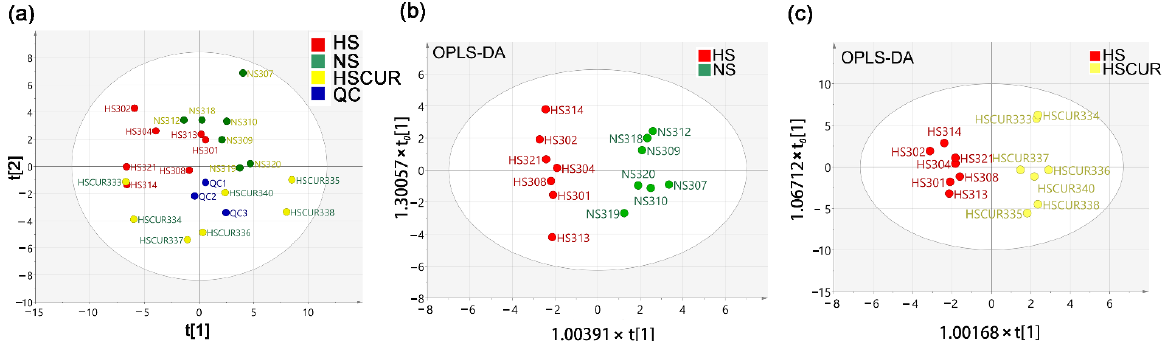
Figure 2. Hepatic metabolomics analysis. Score plot of principal component analysis (PCA) ( a ) and orthogonal partial least squares discriminant analysis (OPLS-DA) between NS and HS ( b ), or HS and HSCUR groups ( c ).